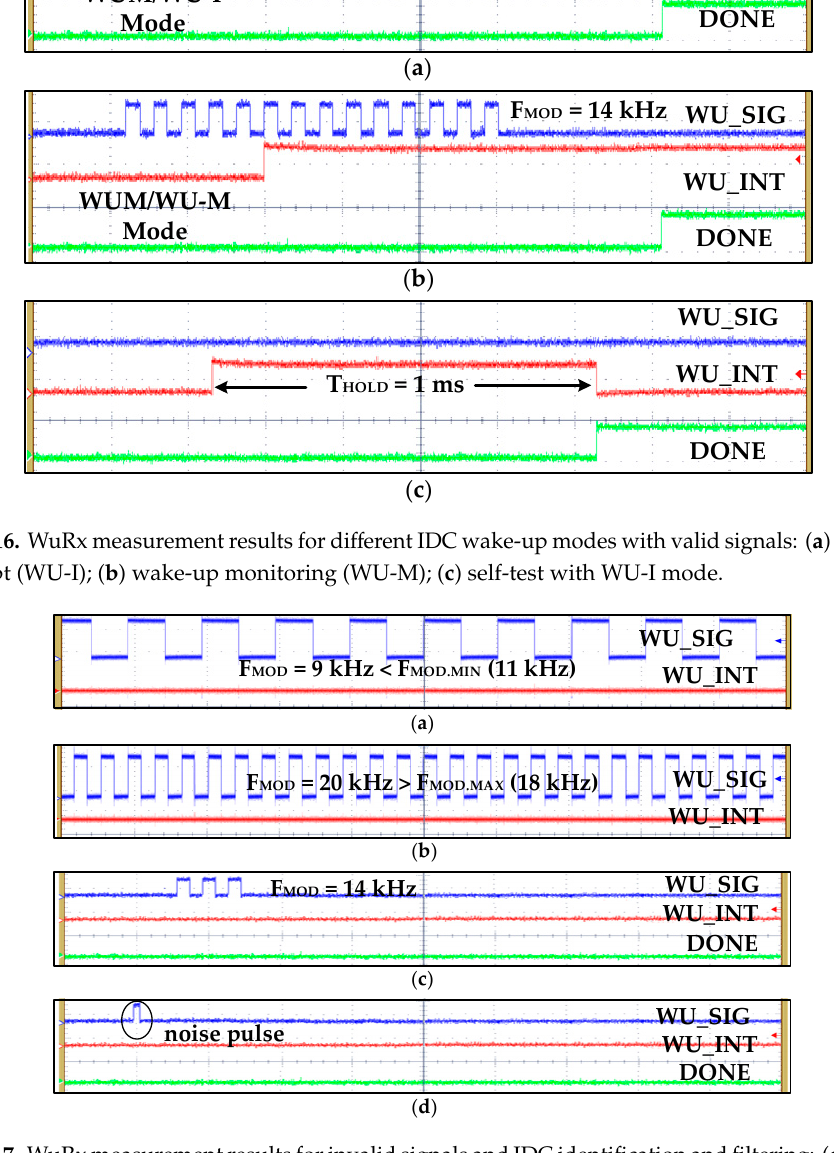
Figure 17. WuRx measurement results for invalid signals and IDC identification and filtering: ( a ) invalid wake-up signal with modulation frequency of 9 KHz, which is less than the minimum hysteresis configured limit of 11 kHz; ( b ) invalid wake-up signal with modulation frequency of 20 KHz, which is greater than the maximum hysteresis configured limit of 18 kHz; ( c ) poor wake-up signal with valid modulation frequency but less number of cycles than the configured value of 5; ( d ) invalid signal of noise pulse.